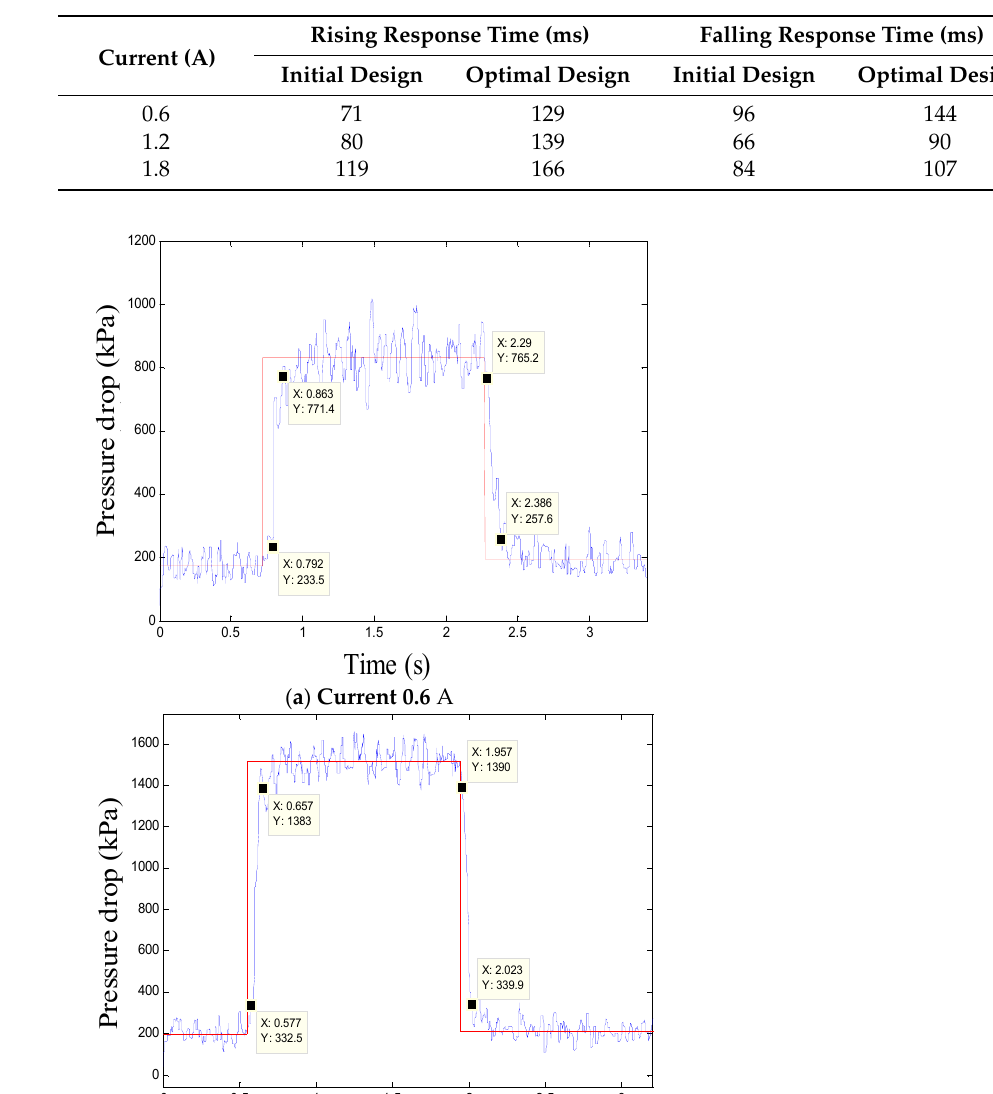
Table 3. Step response time of the initial and optimal MR valve.